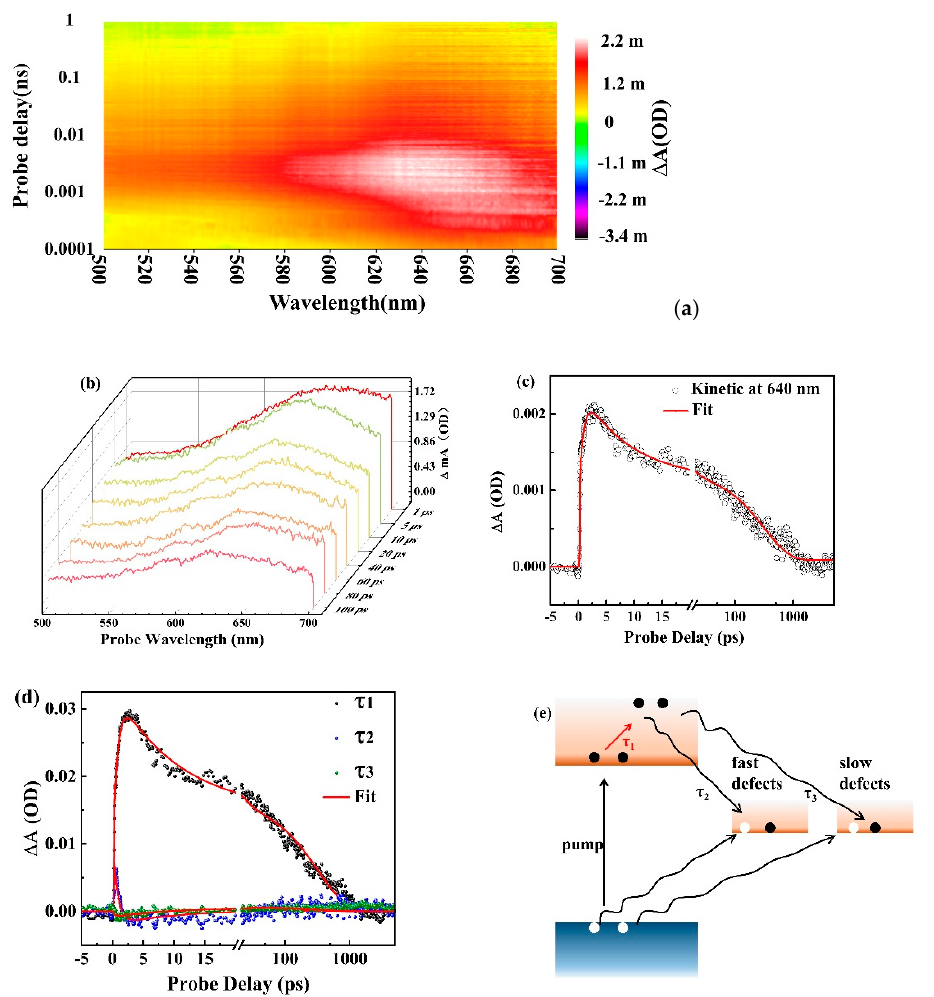
Figure 4. ( a ) The transient absorption map of SnSe NSs as the function of both delay time and probe wavelength. ( b ) The transient absorption spectra of SnSe NSs with a 400 nm pump pulse in the range of 1–100 ps. ( c ) The transient absorption signal measured from SnSe NSs with 640 nm probe pulse. ( d ) The globe fitting analysis of the TA spectra in the range of 500–700 nm. ( e ) Schematic illustration of carrier dynamics in SnSe NSs. The black curved arrows indicate the charge carrier be captured by the defects via Auger process and the red arrow indicate the ESA.